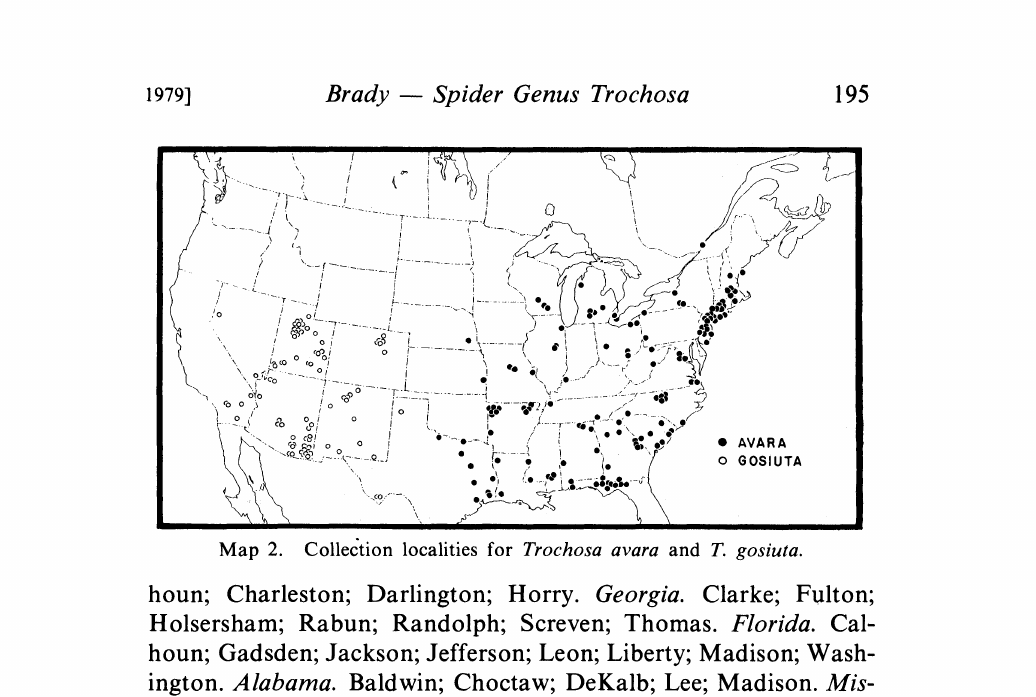
Figs. 19-21. Trochosa avara Keyserling. 19-20. Female from Ramsey, Bergen Co., New Jersey, 24 Sept. 1934. 19. Spermathecae. 20. Epigynum. 21. Epigynum of syntype of Trochosa avara Keyserling, North America.